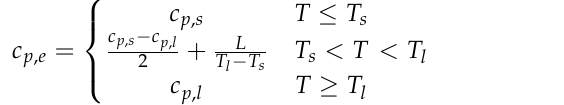
Figure 12. Gas temperature curve used in the simulations.